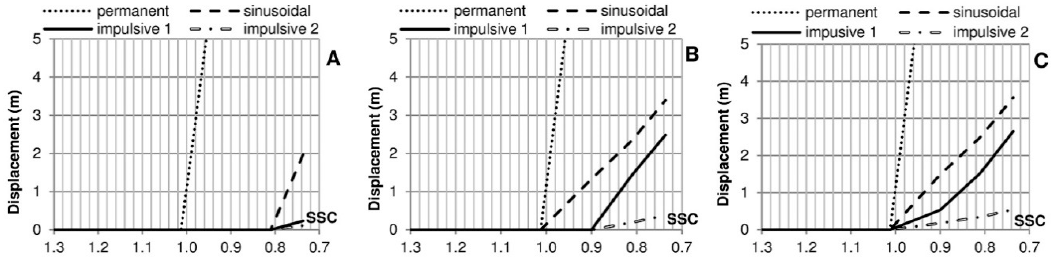
Figure 19. Wall sliding as a function of SSC and the signal shape, assuming elastic soil. ( A ) E (MPa) = 10; ( B ); E (MPa) = 100; ( C ) E (MPa) = 27,000.